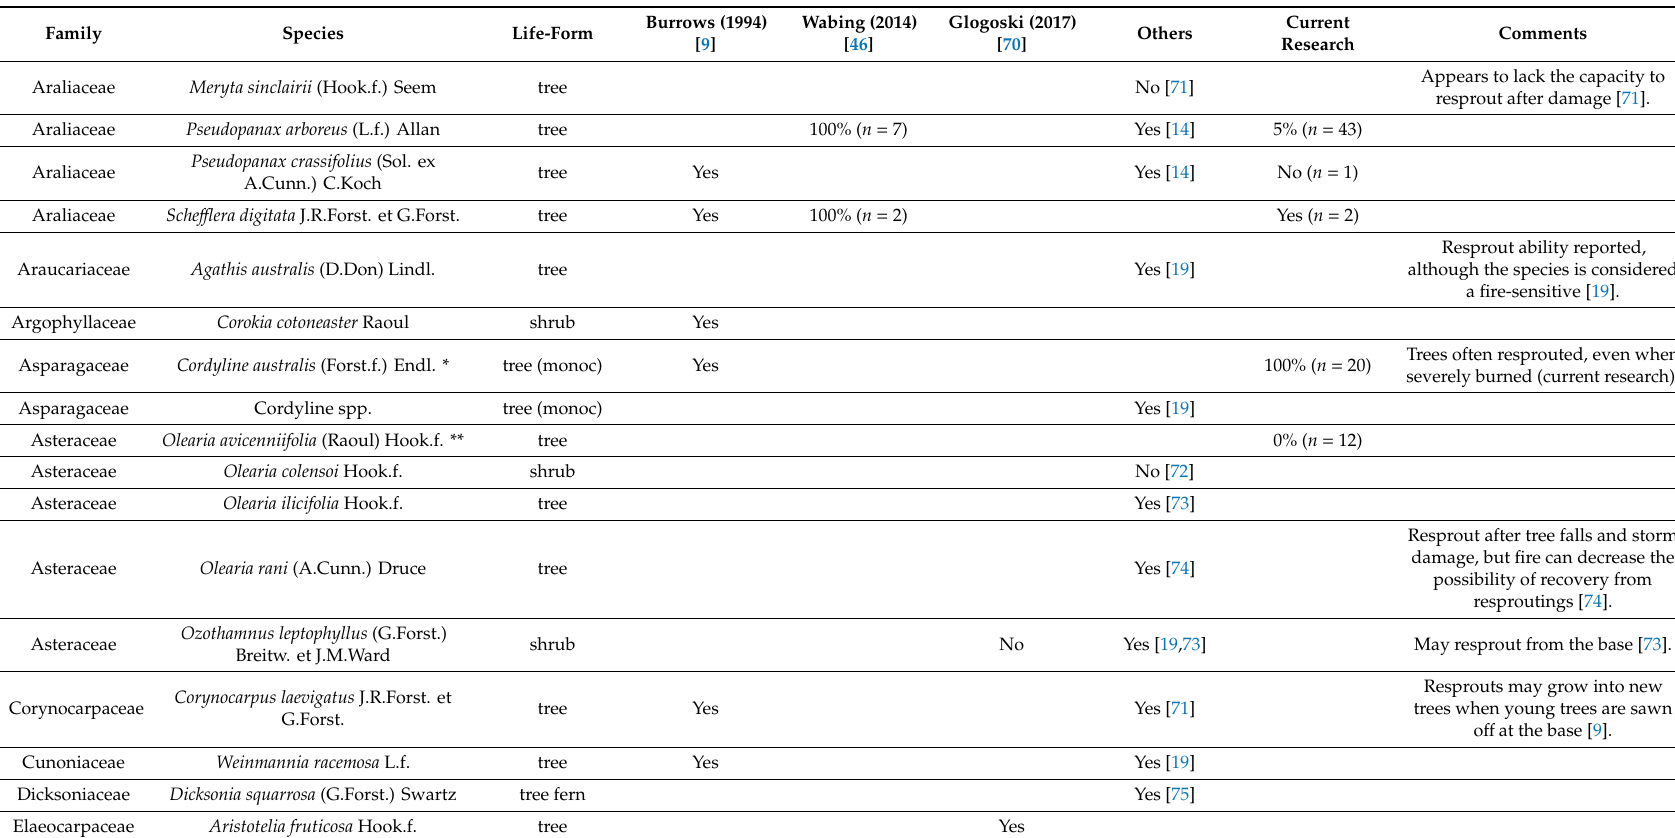
Table A1. Resprouting capacity of New Zealand native trees and